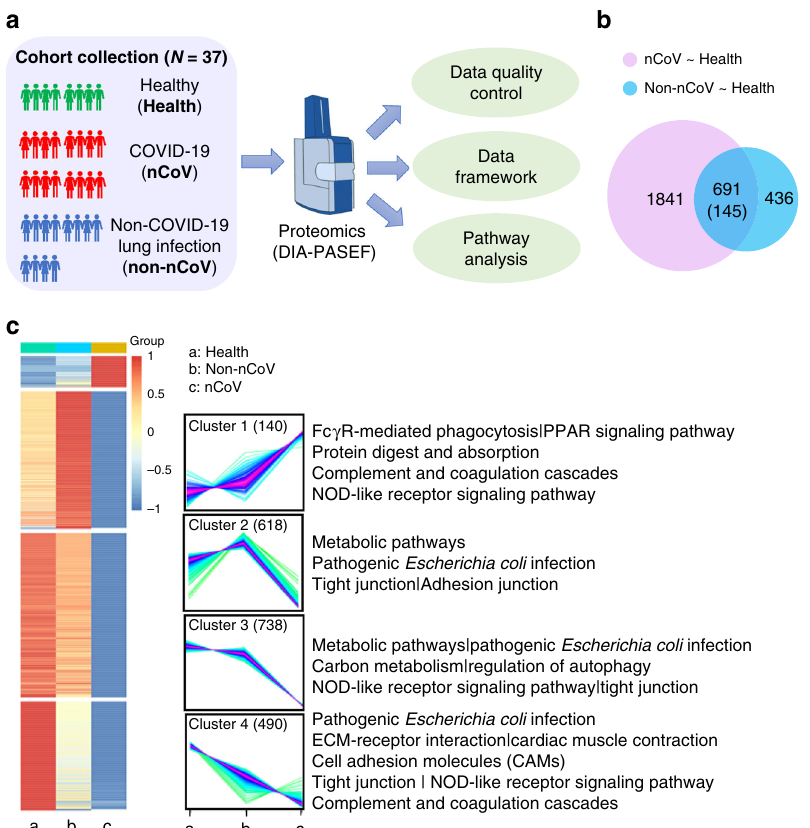
Fig. 1 Quantitative urine proteomic studies. a An illustration of the experimental design. A total of 37 urine samples were analyzed from three groups: healthy controls (10 samples); COVID-19 patients (14 samples); and non-COVID-19 pneumonia patients (13 samples). The data-independent acquisition (DIA) technique was applied for quantitative proteomics, which was performed by trapped ion mobility spectrometry coupled to TOF mass spectrometry (TIMS-TOF MS) with the parallel accumulation-serial fragmentation (PASEF) technique. Integrated data analysis involved protein expression, clustering, and functional correlational network strategies. b Venn diagram of signi fi cantly changed proteins (cut-off value of fold change >2 and fold change <0.5; p value ( t test) <0.05) in the healthy control group compared to the COVID-19 patient group (pink) and to the non-COVID-19 pneumonia patient group (blue). A total of 1841 proteins were signi fi cantly changed speci fi cally in COVID-19 patients compared to healthy controls. Six hundred and ninety-one proteins were changed in both disease groups. Among the 691 proteins, 145 proteins meet the condition of fold change >2 and fold change <0.5, p value ( t test) <0.05. A total of 1986 proteins (the group of 1841 proteins and the group of 145 proteins) were used for functional analysis. c Proteomic changes in COVID-19 patients. Heatmap of 1986 proteins in COVID-19 patients in the comparison between healthy controls and non-COVID-19 patients. The color bar from red to blue represents the fold change from increasing to decreasing of all proteins identi fi ed in each group. Hierarchical clustering shows a clear group differentiation according to similarity. Numbers of proteins, intensity pro fi les, and selected enriched KEGG pathways are indicated for marked clusters. Color bar represents Z -score change from − 1 to